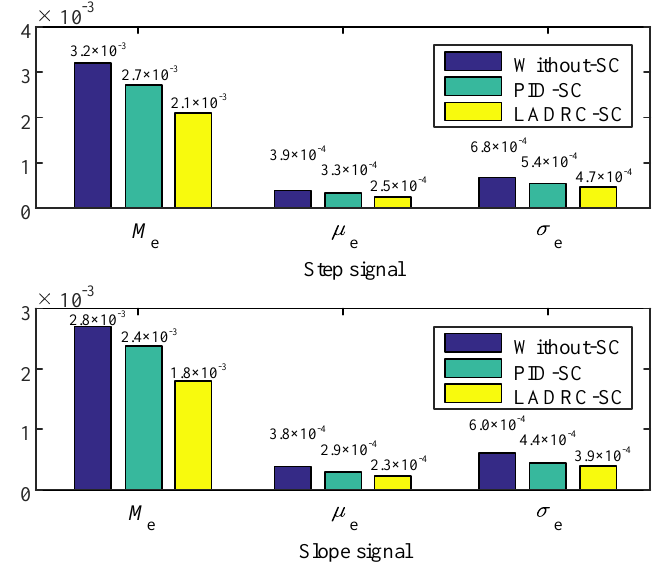
Figure 15. Performance indexes of different control schemes.